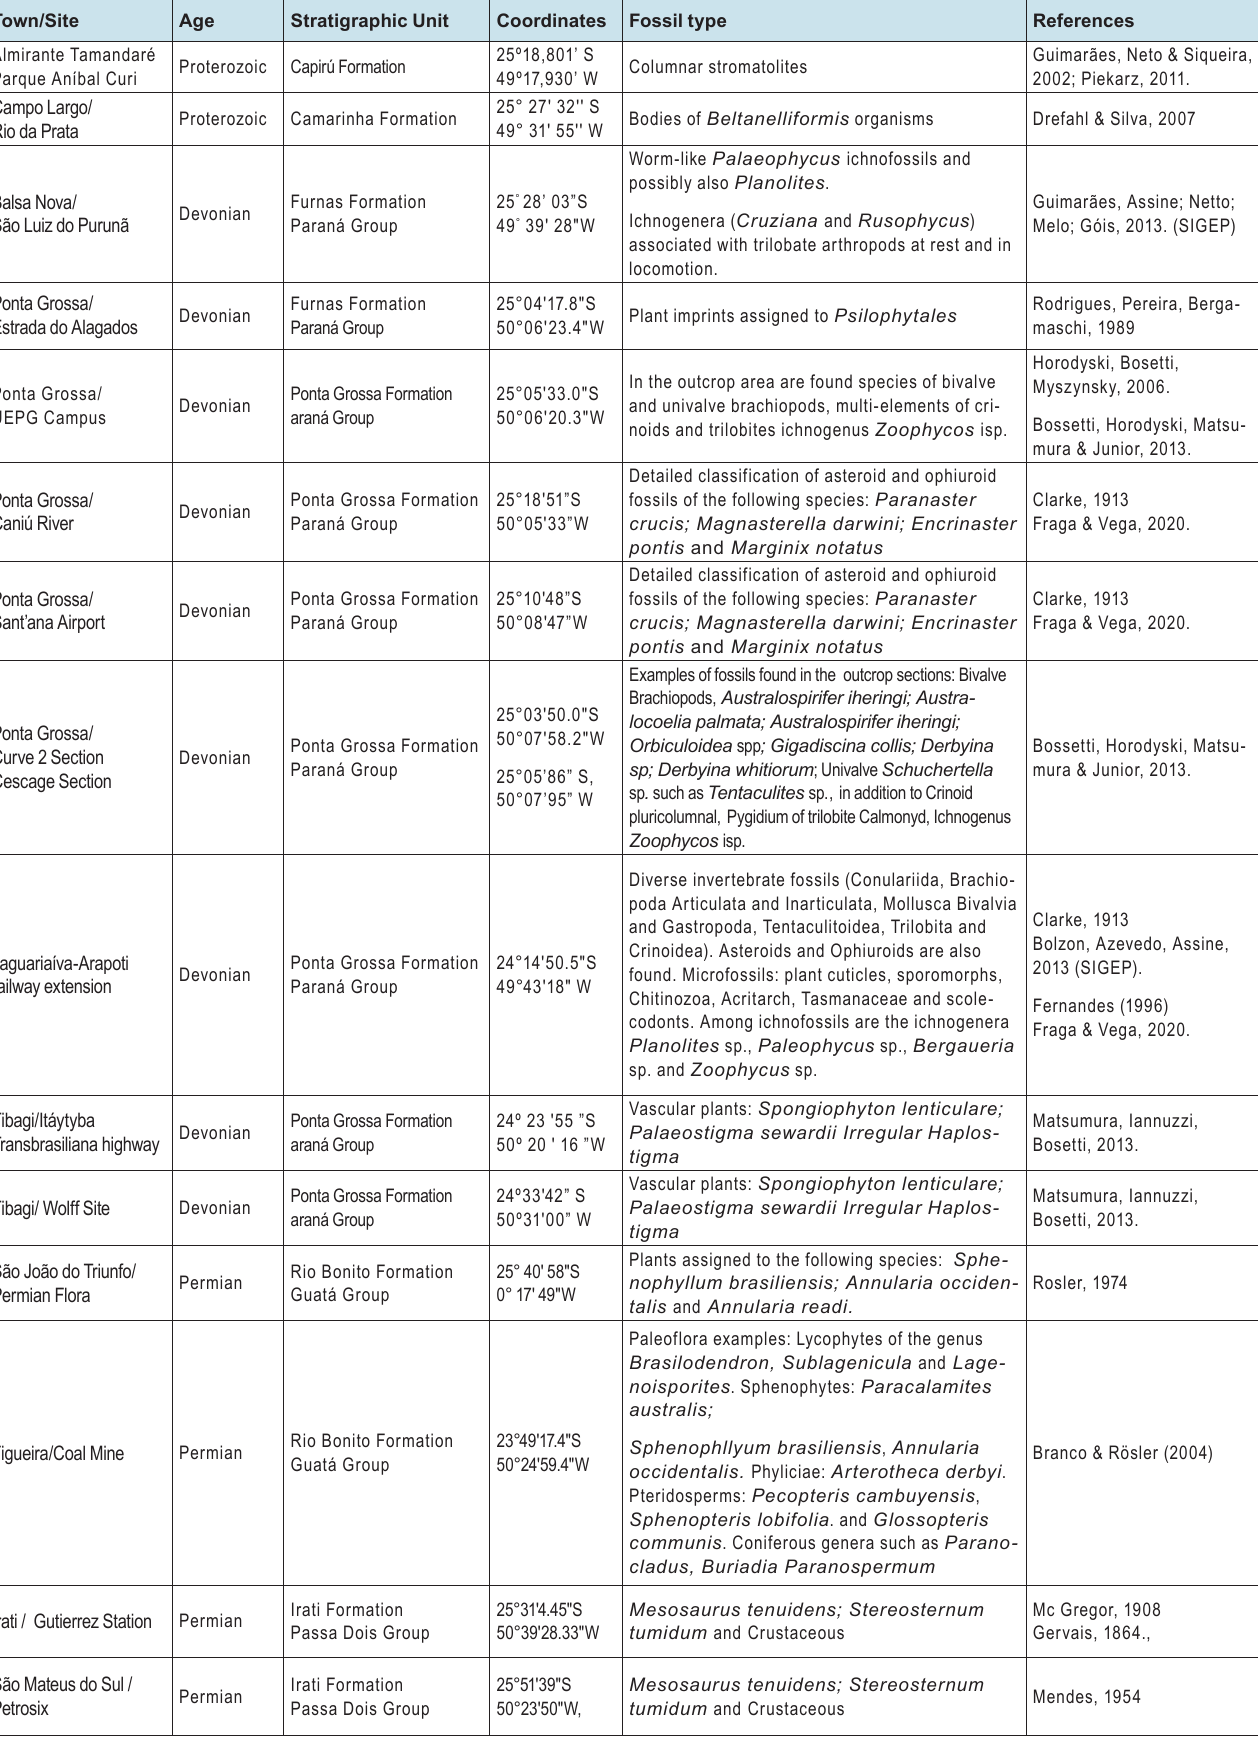
Table 1: Main paleontological sites in Paraná State